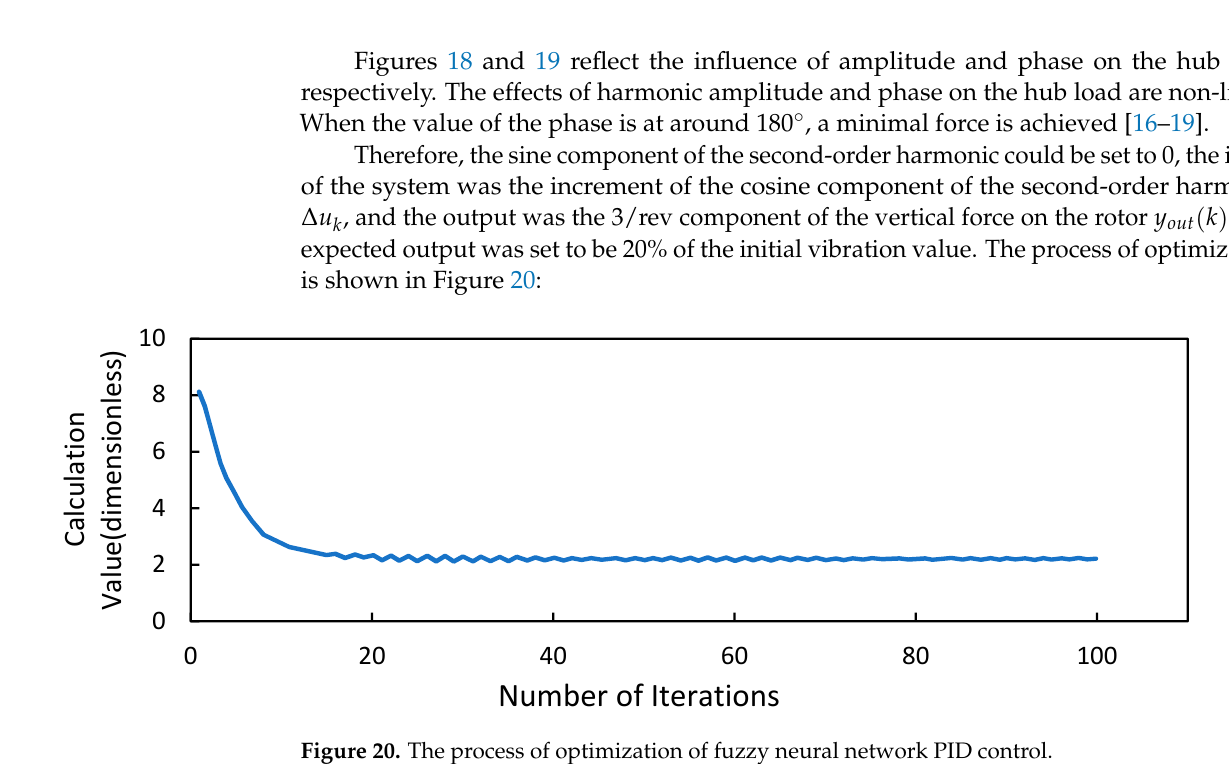
Table 2. Particle swarm optimization